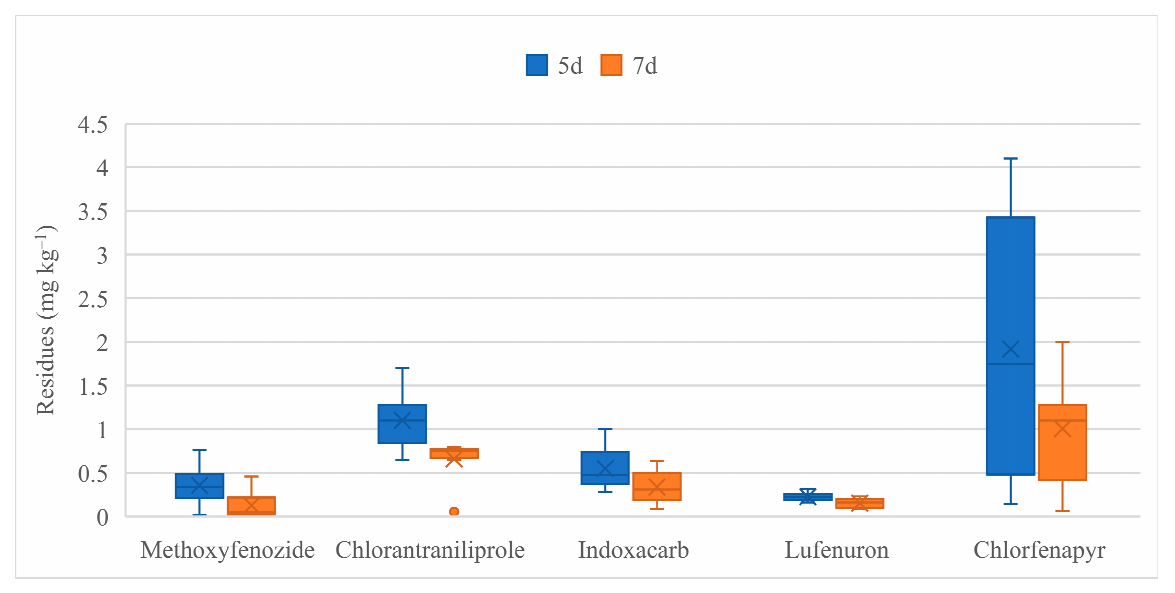
Figure 3. The terminal residues of the five compounds in spinach at different sample intervals. Table 4. Acceptable daily intake (ADI) of the five compounds and the maximum residue limit (MRL) for